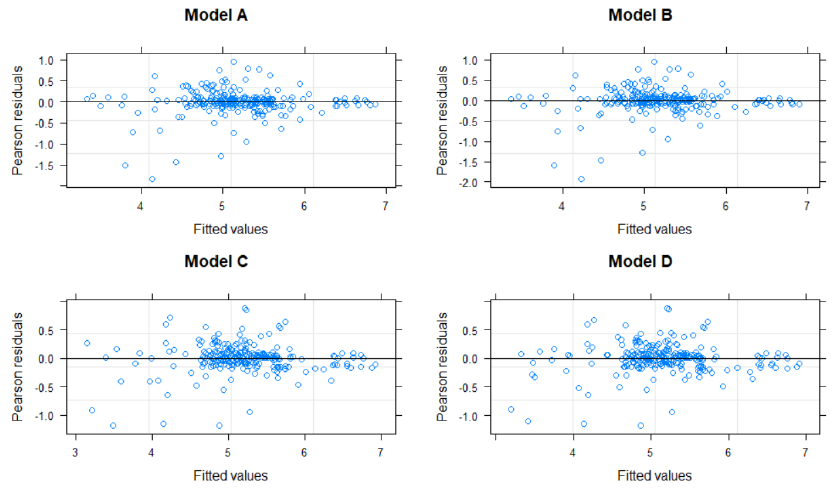
Figure A4. Residuals plotted against fitted model values.